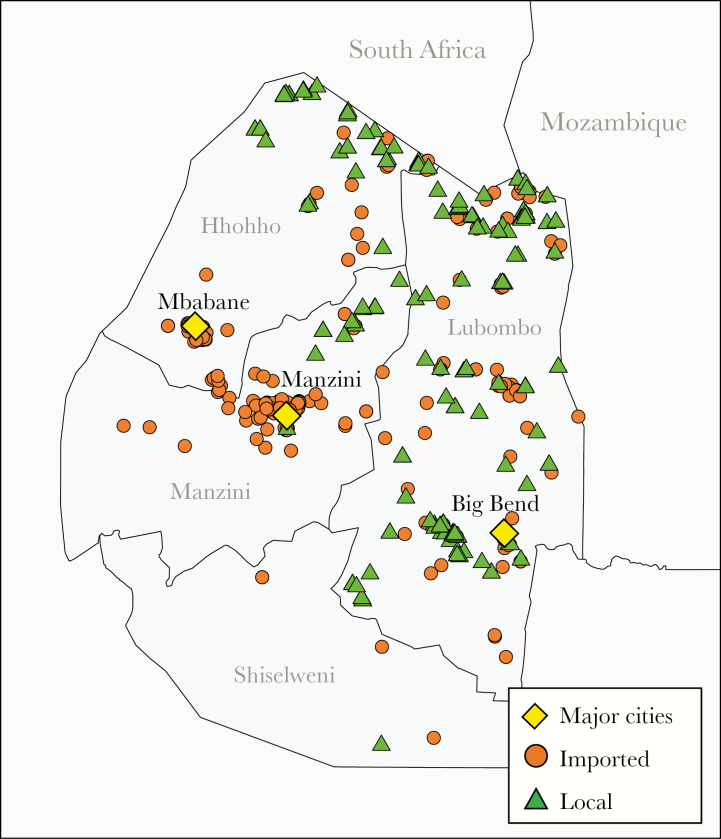
Map of Eswatini cases detected between July 2014 and June 2016. Orange circles represent imported cases and green triangles represent local cases. Yellow diamonds designate major Eswatini cities.